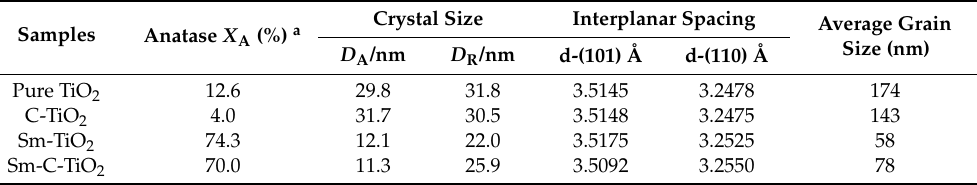
Table 1. XRD results of the different TiO 2 samples calcined at 500 ◦